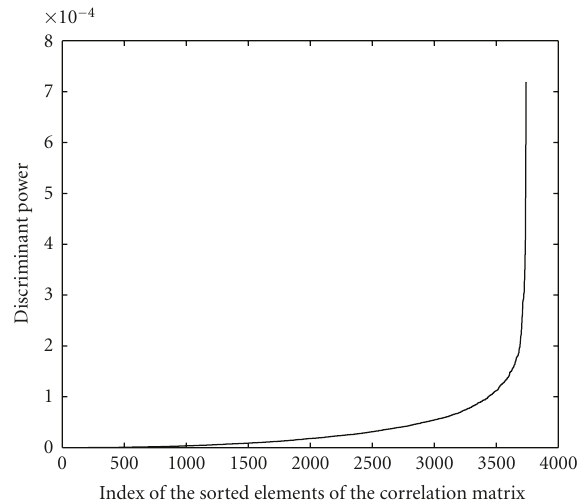
Figure 9: Discriminant power of the 3741 correlations for the samples of the training set.